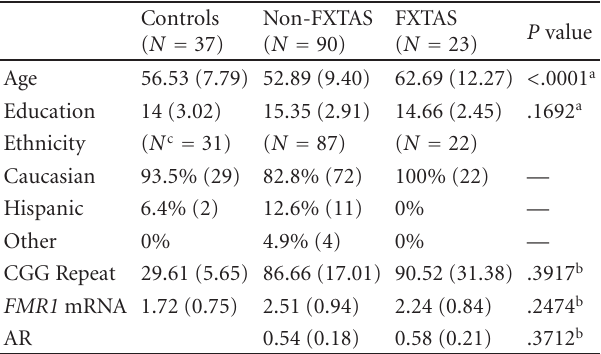
Table 1: Patient